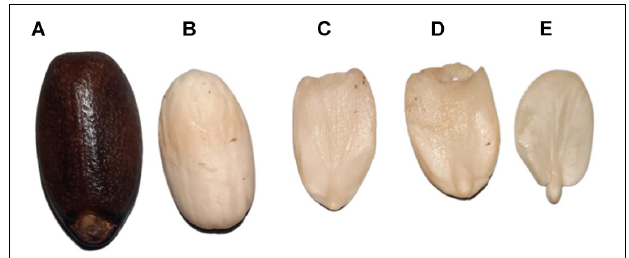
FIGURE 1 | The mature seed of Jatropha curcas. (A) Mature seed with seed coat. (B) Mature seed without a seed coat. (C,D) Endosperm. (E) Embryo.